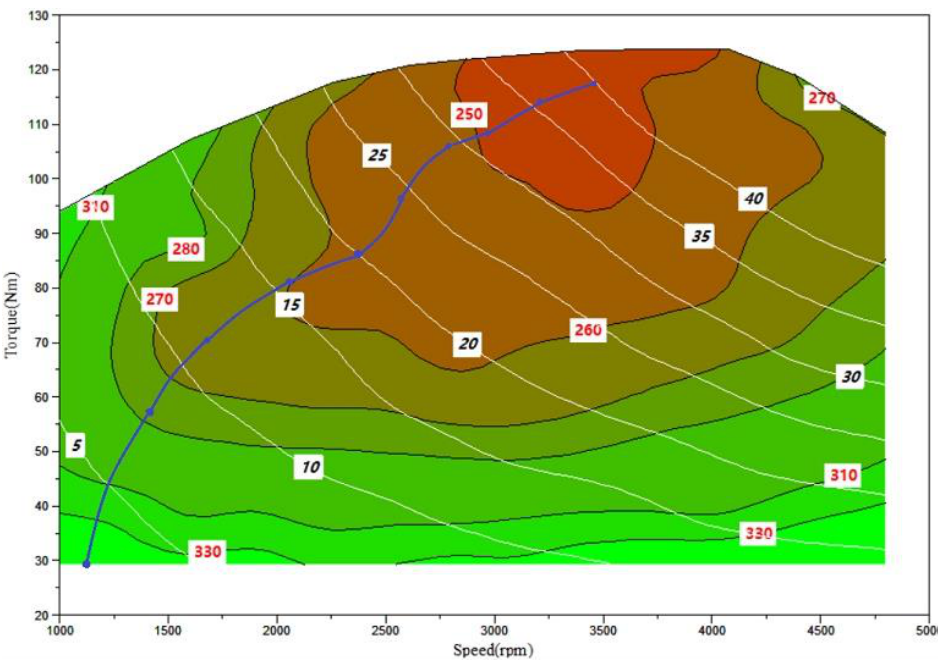
Figure 5. Fuel consumption rate map of the range extender (fuel consumption in red and engine power in black).